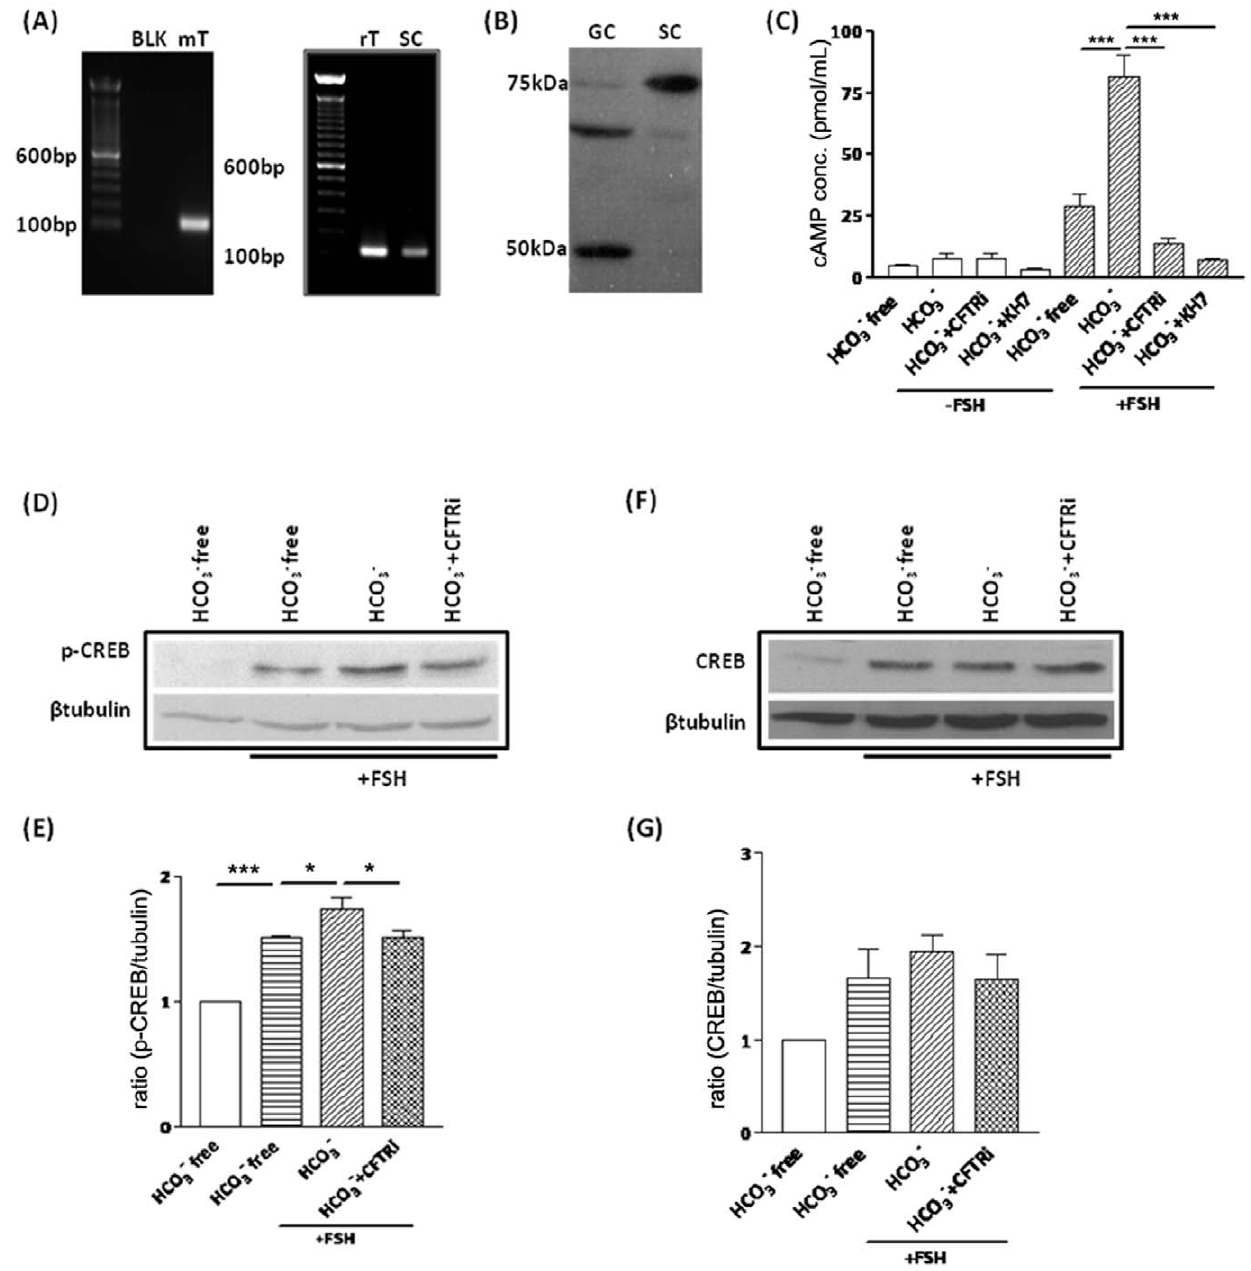
Figure 3. Involvement of CFTR-mediated HCO 3 2 transport in FSH-stimulated cAMP production and CREB regulation. ( A ) RT-PCR result shows the expression of sAC in mouse testis (mT), rat testis (rT) and primary Sertoli cells (SC) (expected PCR product size: 119 bp). ( B ) Western blot shows the expression of a 75 kD isoform of sAC in the Sertoli cells (SC). Adult rat germ cell (GC) sample shows predominatly exression of 50 kD, with another unidentified band. ( C ) Effect of HCO 3 2 , CFTR and sAC inhibitors on 50 ng FSH-stimulated cAMP production, with presence of 25 mM HCO 3 2 potentiating FSH-stimulated cAMP production in Sertoli cells, which is abolished by 10 m M CFTRinh172 and 10 m M sAC inhibitor KH7. (n=3; ***:p , 0.01). ( D-E ) Effect of HCO 3 2 and CFTR inhibitors on FSH-stimulated CREB phosphorylation. Western blot results shows that 25 mM HCO 3 2 potentiates 50 ng FSH-stimulated CREB phosphorylation in Sertoli cells, while 10 m M CFTRinh172 attenuates the effect of HCO 3 2 (n=3; *:p , 0.05; ***:p , 0.001). ( F-G ) Effect of HCO 3 2 and CFTR inhibitor on CREB expression. Western blot results shows that removal of HCO 3 2 or treatment with CFTRinh172 slightly decrease total CREB level in the presence of FSH, but without statistic significance (n=3). Statistic data are shown as mean 6 SEM. Detailed protocol in Materials and Methods. doi:10.1371/journal.pone.0019120.g003 donkey anti-goat IgG-HRP (1:5000) in 2% milk for 1 hour at CREM 1:200) in 2% milk at 4 u C overnight. Membranes are room temperature. Following three washes in TBS-T, proteins are washed three times in TBS-T followed by incubation with anti- detected using an enhanced chemiluminescence kit according to mouse IgG-HRP (1:10000), anti-rabbit IgG-HRP (1:10000) or the manufacturer’s instructions.